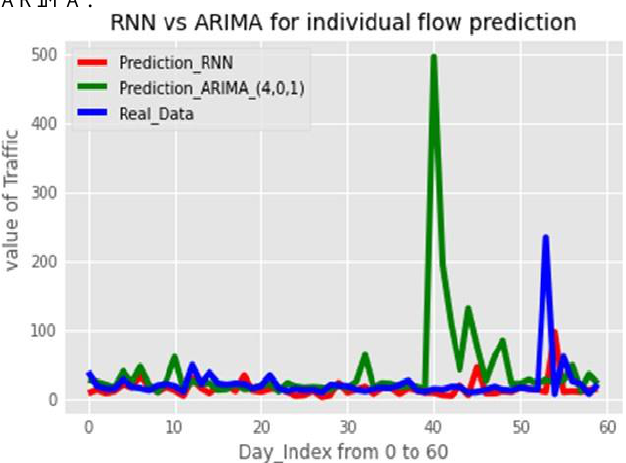
Figure 11. RNN predictor and AdaBoost predictor for 400 training samples. Figure 12. RNN predictor and AdaBoost predictor for 300 training samples-single